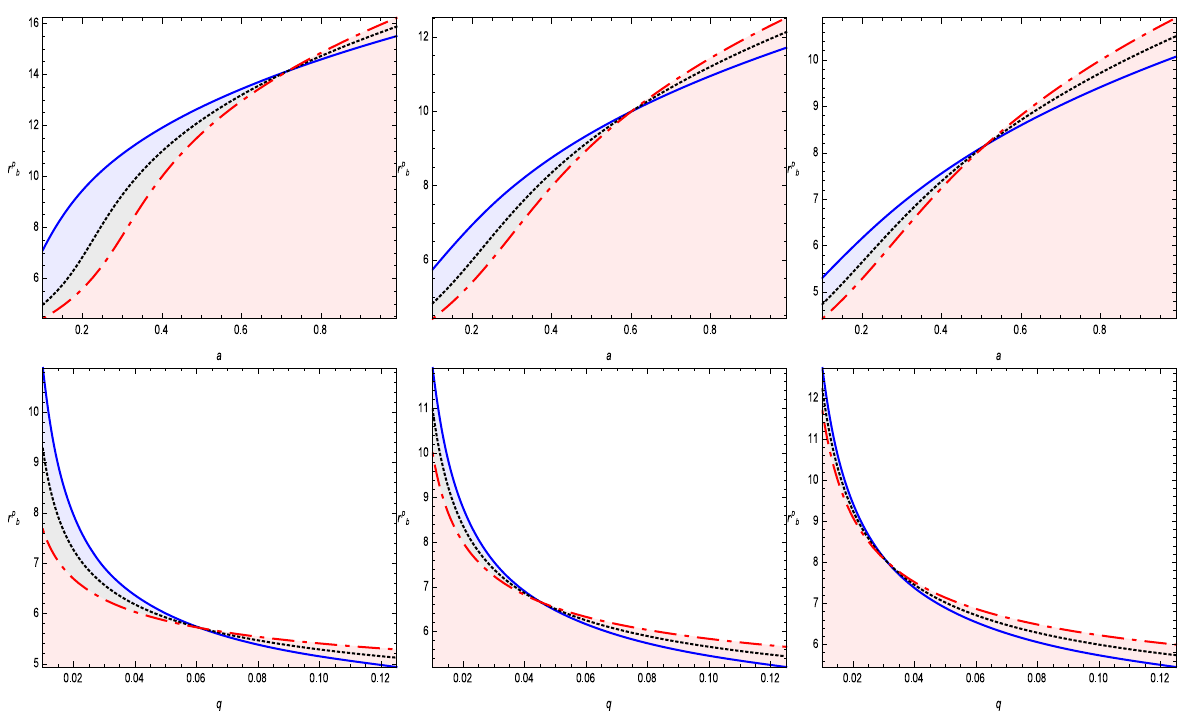
√ 12 with q = 0 . 03. The left panel of the second row represents L = √ √ √ (blue), L = 16 (black), and L = 20 (red) with a = 0 . 1. The middle √ √ 12 (blue), panel of the second row represents L = 12 (blue), L = 16 (black), √ √ and L = 20 (red) with a = 0 . 3. The right panel of the second row √ √ √ 16 (black), represents L = 12 (blue), L = 16 (black), and L = 20 (red) with √ a = 0 . 20 (red)